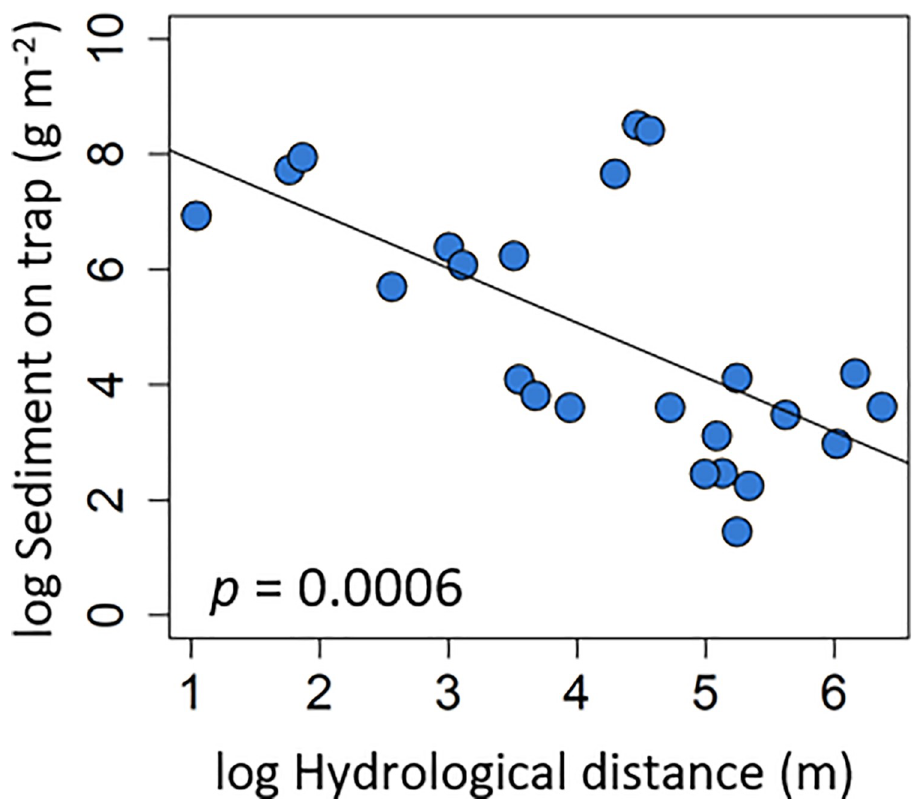
Fig 4. Sedimentation on traps. Sedimentation on traps explained by log hydrological distance.